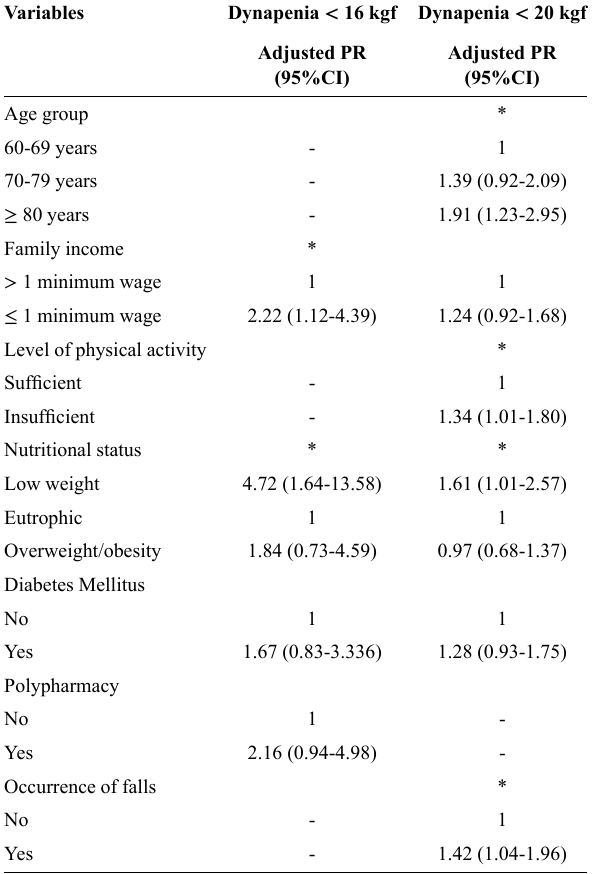
Table 3 - Final hierarchical model of the association between dynapenia (HGS < 16 kgf and HGS < 20 kgf) and the independent variables in the study population. Jequié-BA, Brazil,